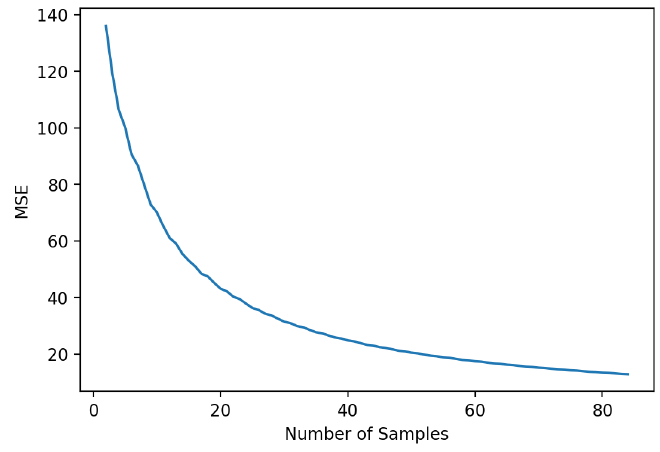
Figure 10. Cross-validation training score of nonlinear